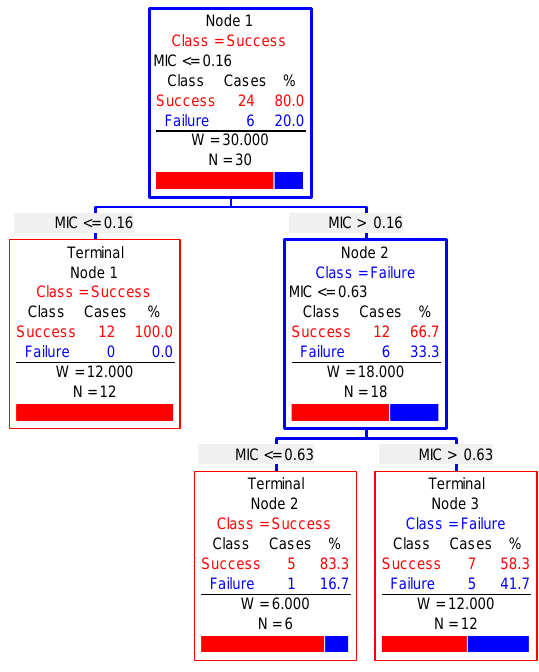
Figure 7. The simulation of CART modeling. Nonlinear regression analysis was performed to obtain the equation expressing the relationship between log 2 MIC and cure rate. The equation was y = −1 .144x 2 − 12.831x + 64.812, and R 2 (the correlation coefficient) was 0.99. When the cure rate equaled 90%, the corresponding log 2 MIC value was approximately −1, and the MIC value was 0.5 μg/mL, which accorded with the range of 0.16 – 0 .63 μg/mL. Consequently, the CO CL was defined as 0.5 μg/mL.